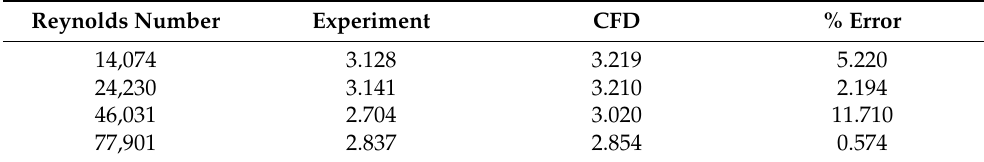
Figure 5. Comparison of the TPLC for different Reynolds numbers [2]. Table 1. Comparison of % error between experimental and simulation results.